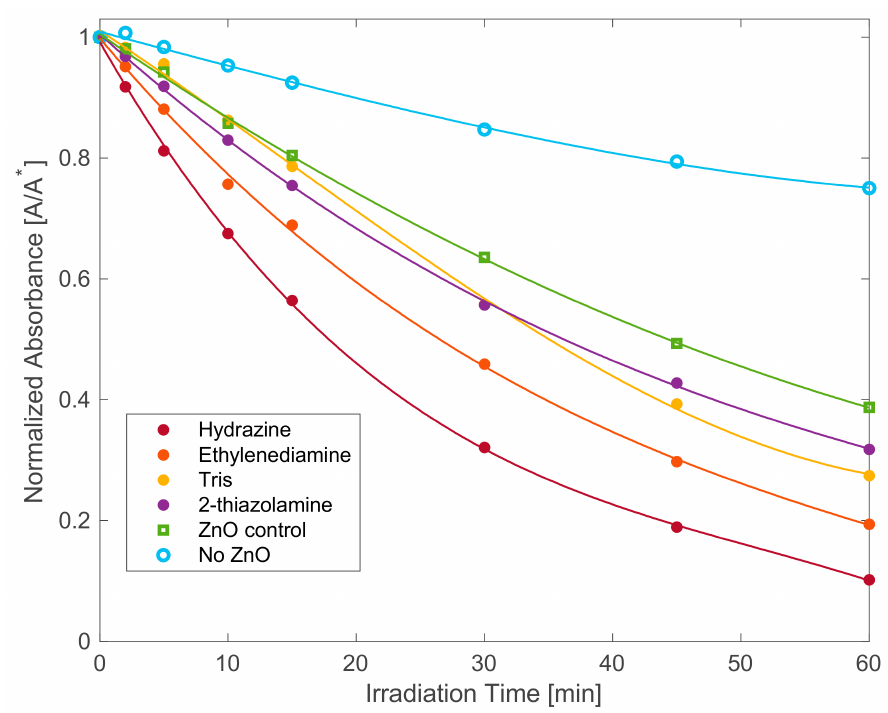
Figure 7. Absorption data for the decolorization of malachite green solutions using differ- ent zinc oxide photocatalysts prepared by rapid precipitation. The amines used to make the [Zn(acetate) 2 (amine) x ] precursors are identified by the labels in the legend. The ZnO control was prepared using Zn(NO 3 ) 2 without added amines. “No ZnO” corresponds to the decolorization of malachite green with no catalyst in solution under